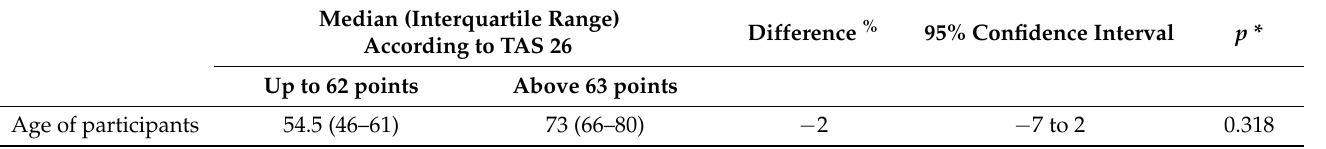
Table 2. Alexithymia based on the patients’ ages.